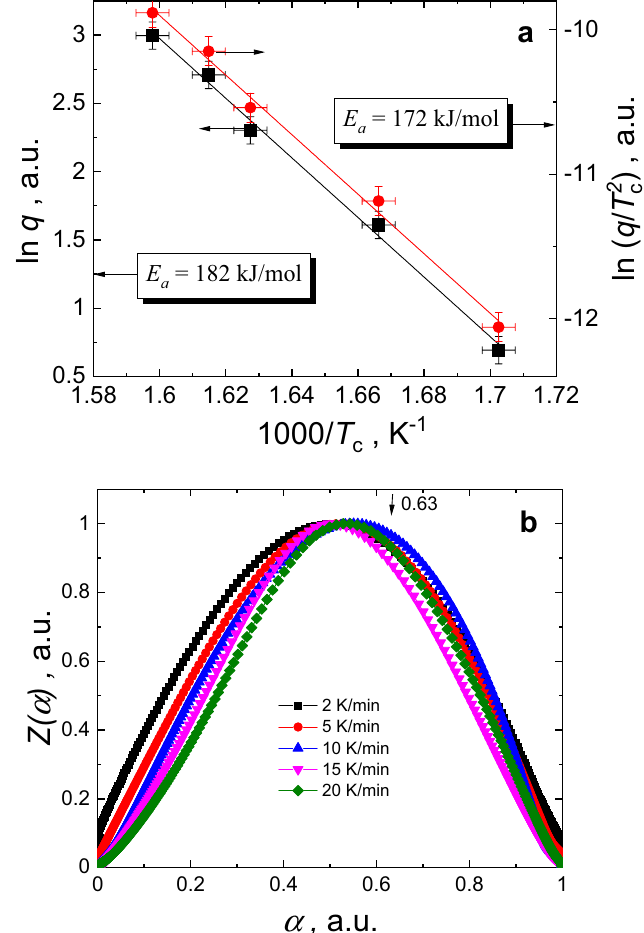
Figure 4. Thermodynamic parameters calculated from DSC data. ( a ) Ozawa’s and Kissinger’s plots for activation energy calculations. ( b ) Probe z ( α ) curves, calculated from DSC data of the as-prepared bulk Ge 15 Sb 40 S 15 Se 15 Te 15 glass, showing peak values shifted from 0.63 position required for JMA model to be